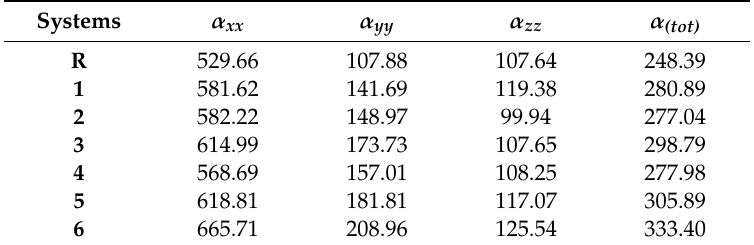
Table 2. Dipole polarizabilities and major tensor (a.u.) of the studied compounds R and 1 – 6 in the gas phase at the B3LYP / 6-31G(d,p) level of theory.